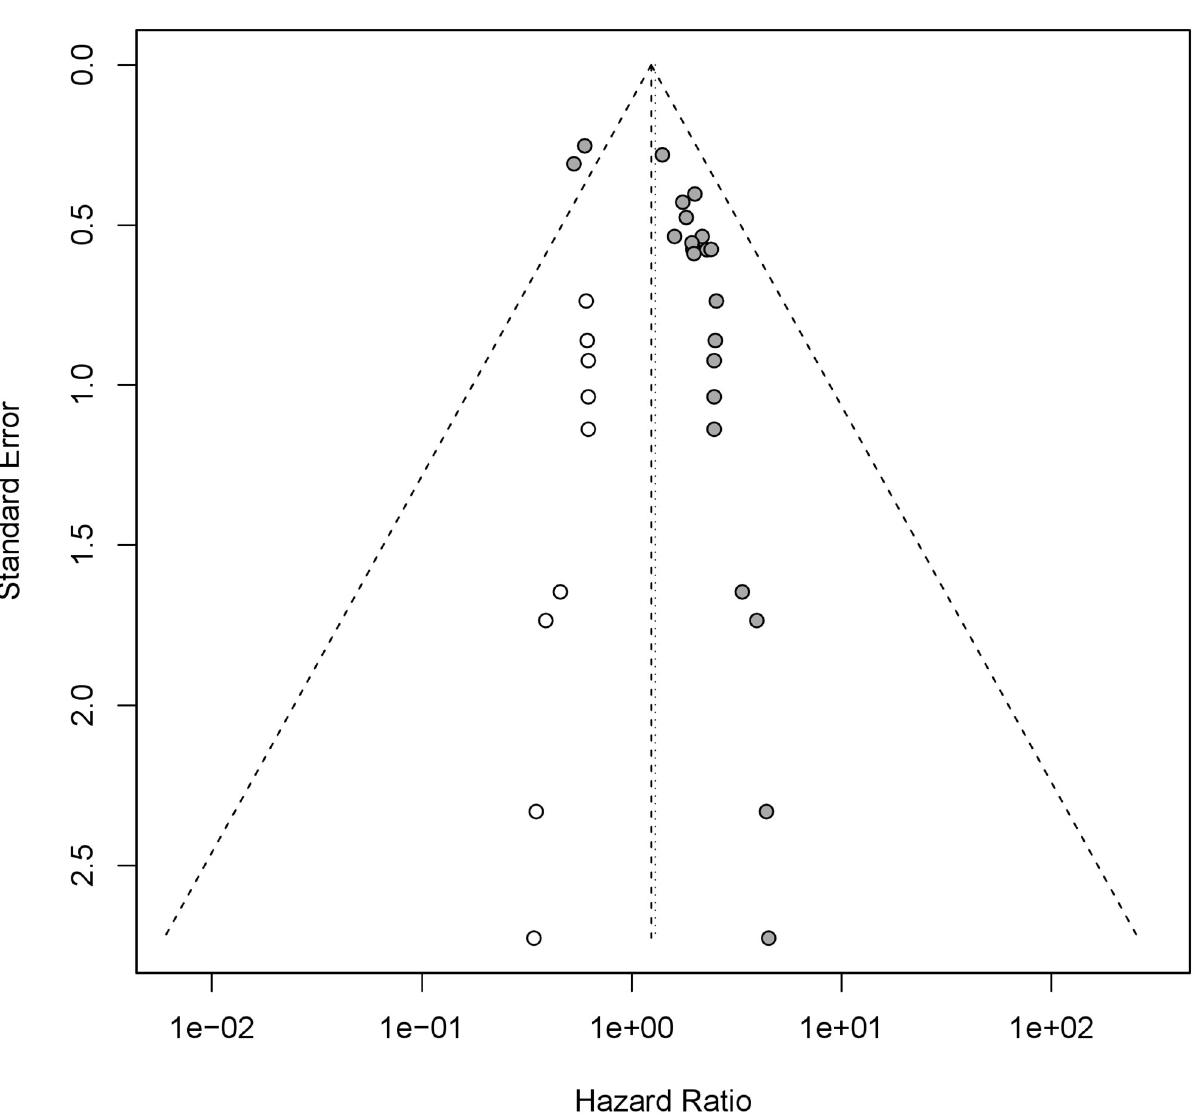
Fig 8. Publication bias was corrected by trim and filling method. (A)The hollow circle on the left side was supplementary studies by trim and filling method. (B)9 additional studies were supplemented to control publication bias, the result of which showed that the expression level of mucin family was still related to the prognosis of patients with pancreatic cancer (HR = 1.24,95%CI 1.01–1.52).